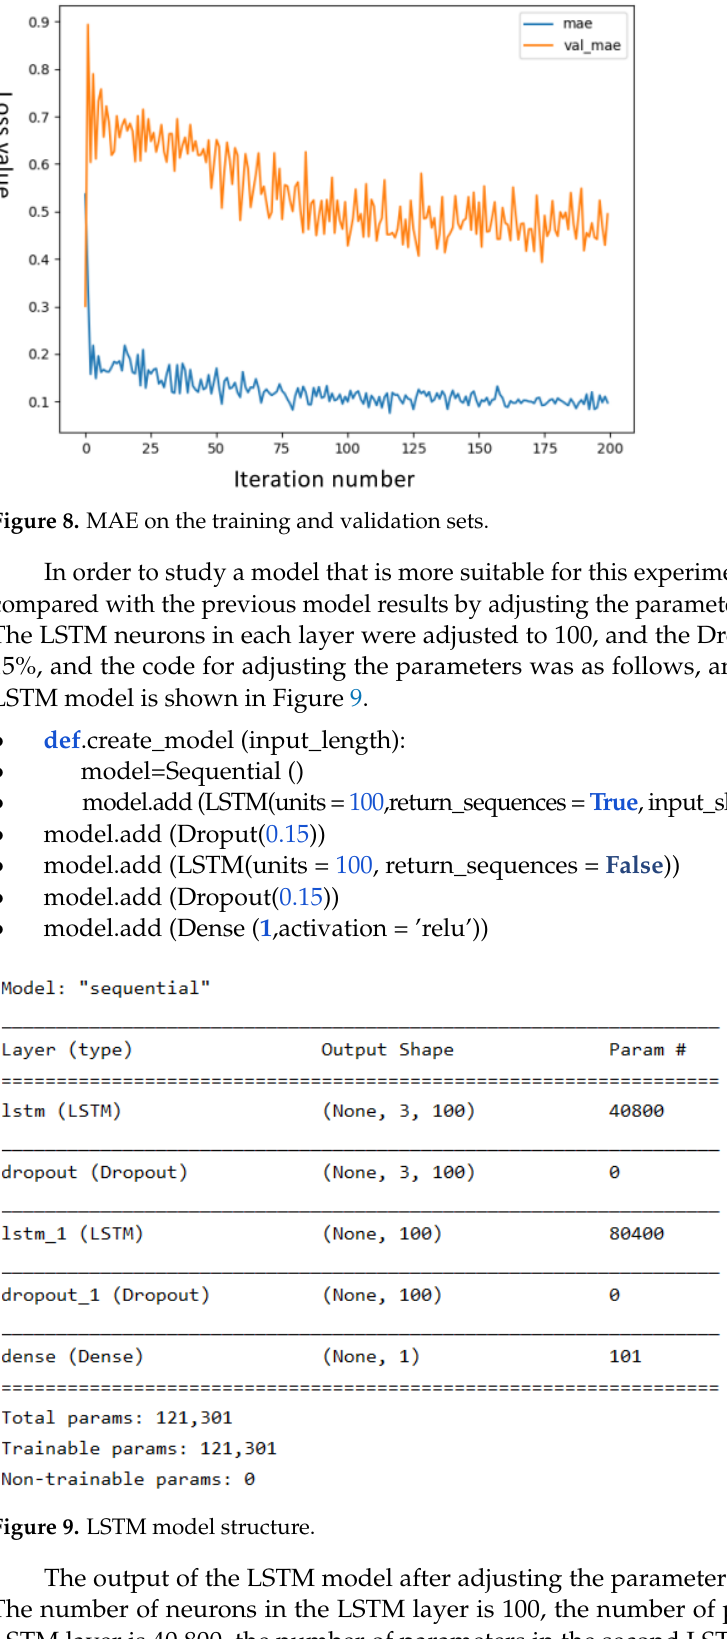
Figure 7. MSE on the training and validation sets.